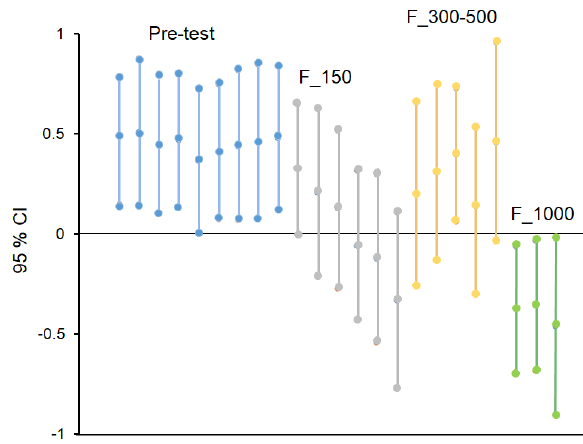
Figure 4. An ensemble of confidence intervals (95%) from the regression models listed in Table 3. The labels align with the first CI of that category. Light blue, grey, yellow and green color bars represent CIs for the pre-test, < 150 ms fixation duration, 300- 500 ms fixation duration and > 1000 ms fixation duration, respec-